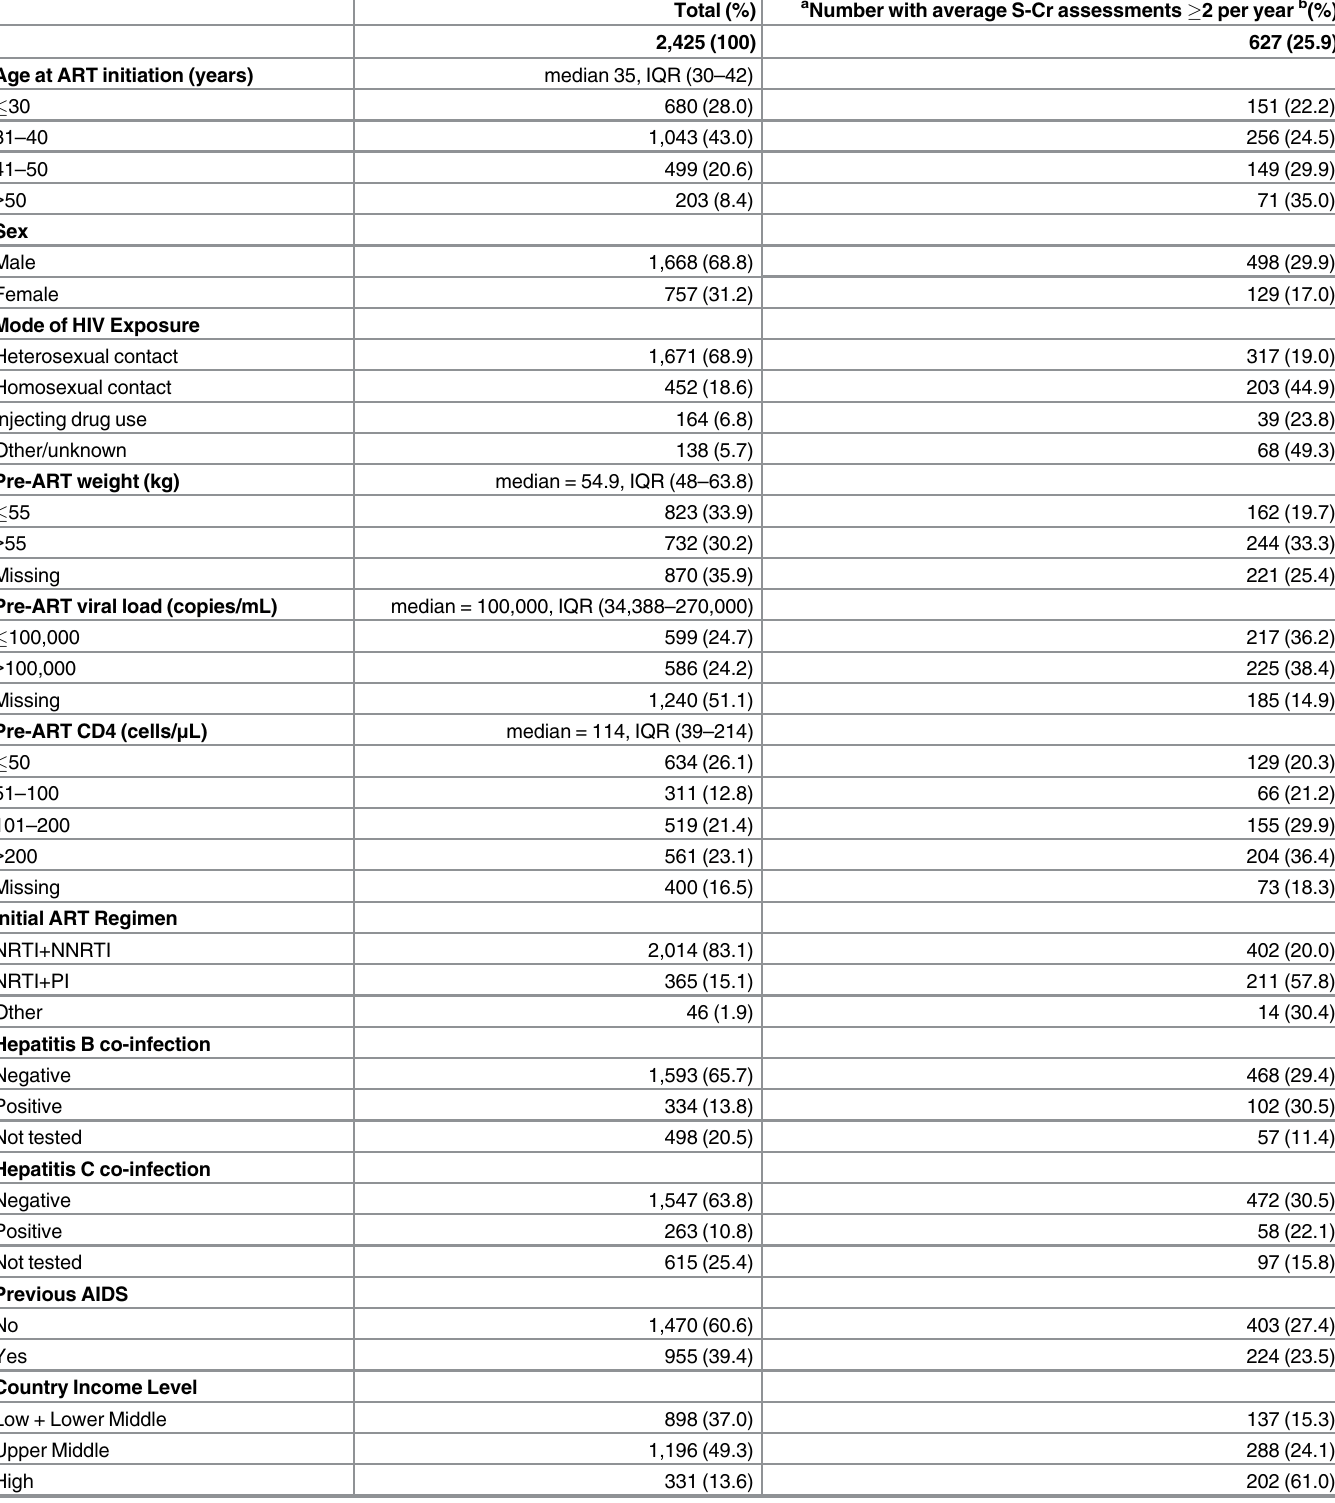
Table 1. Baseline demographics of patients who have ever received